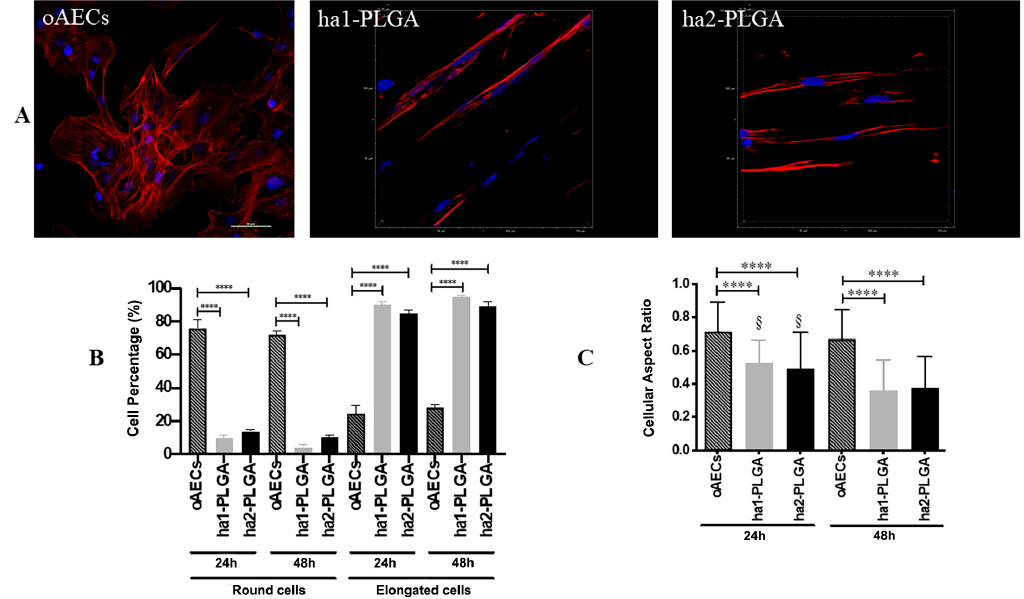
Figure 7. Morphology of oAECs on ha1-PLGA and ha2-PLGA fleeces. ( A ) Representative confocal images of oAECs morphology evidenced with phalloidin stain (red fluorescence) and nuclei counterstained with DAPI (blue fluorescence). It is evident that oAECs on Petri dishes maintain their typical epithelial shape, whereas they acquire a tenocyte-like elongated morphology already at 24 h culture on both ha1- and ha2-PLGA fleeces. Scale bar = 50 µ m. ( B ) Percentage of the elongated oAECs after 24 h and 48 h seeding on ha-PLGA fleeces. **** Statistically significant values between the di ff erent studied groups at each time point ( p < 0.0001). ( C ) Percentage of the cell nuclei aspect ratio after 24 h and 48 h seeding on ha1-PLGA and ha2-PLGA fleeces. **** Statistically significant values between the di ff erent studied groups at each time point ( p < 0.0001). § Statistically significant values within the same group at di ff erent time points ( p < 0.0001) (n = 3 for each type of fleece / analysis, fleece size: 15 mm × 7